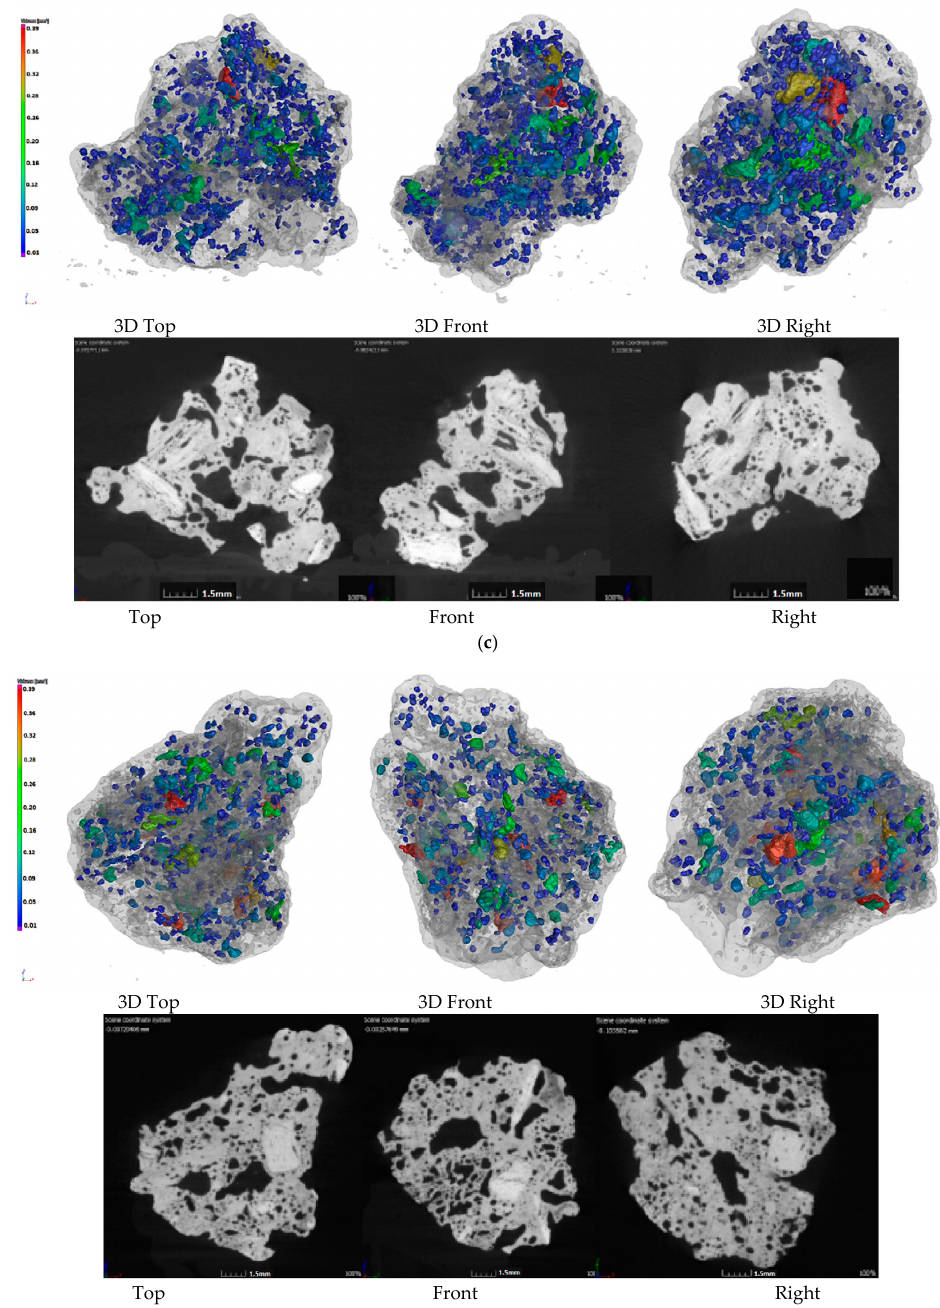
Figure 2. Pore structure of sinter with different charcoal content. ( a )100% Coke; ( b ) 80% Coke + 20% Charcoal; ( c ) 60% Coke + 40% Charcoal; ( d ) 40% Coke + 60% Charcoal.